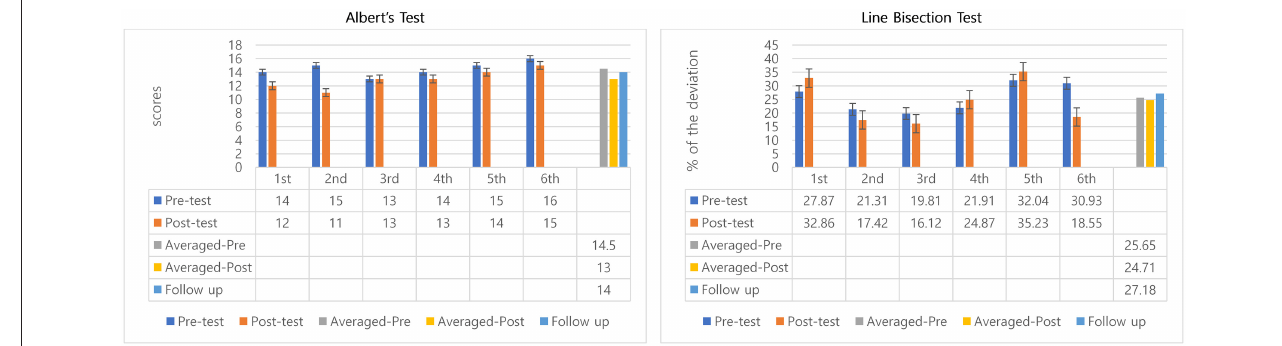
FIGURE 2 | Descriptive data for participant 1’s Albert’s test and line